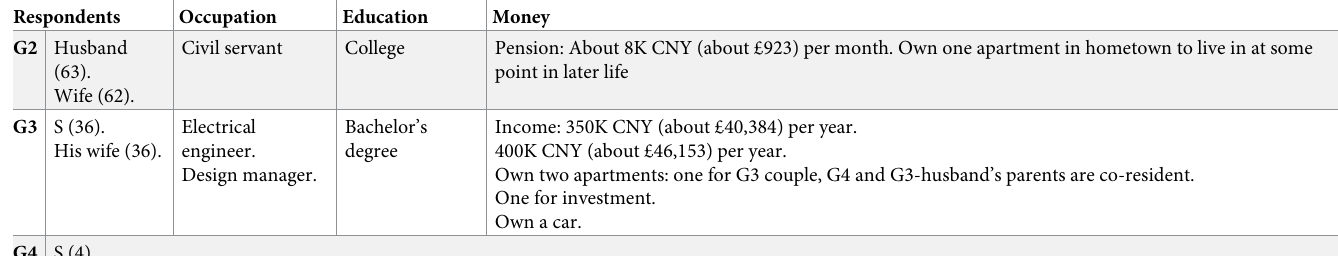
Table 4. Resources of the Han